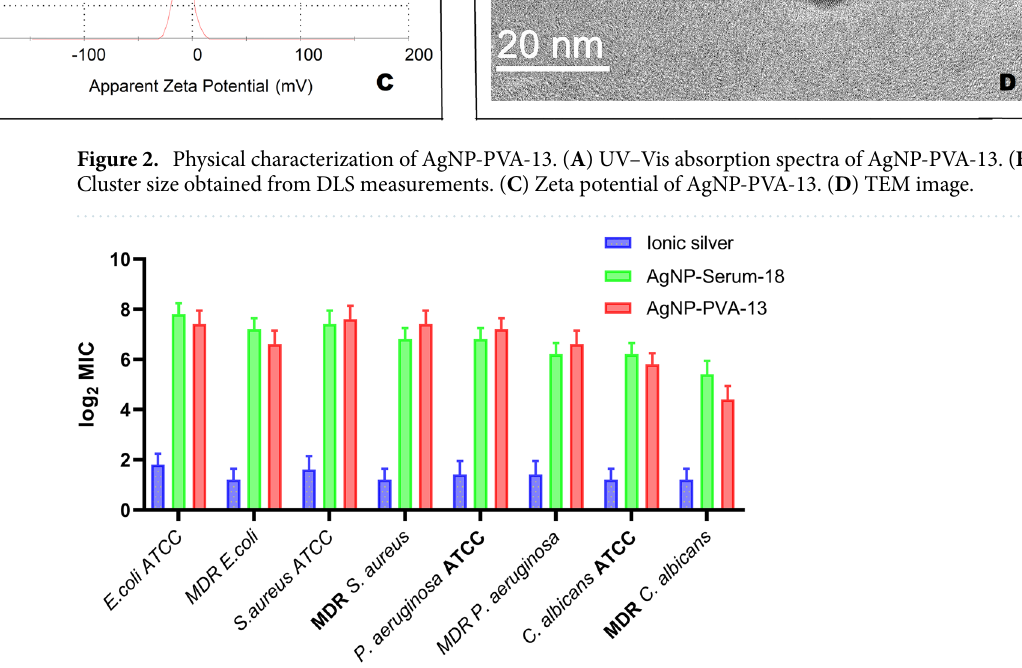
Figure 3. Added anti-microbial action of silver by shifting MIC (log2 MIC dilution factors 2, 4, 8, …256, 512-fold) of AgNPs and AgNO 3 containing 107 μg silver/mL in undiluted form taken as 0 for Y axis and test organisms at X axis). Data are expressed as means ± SD. There was significant difference between the AgNP- Serum18 and Ionic silver groups (P <